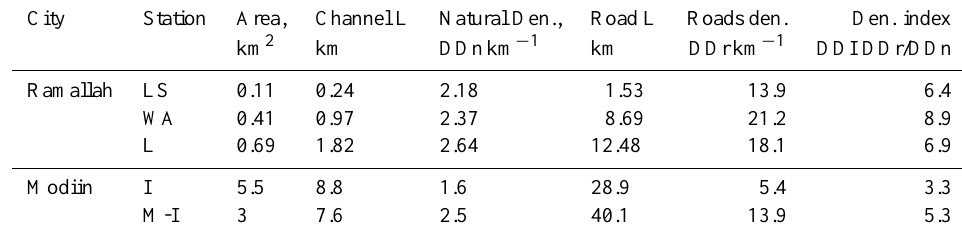
Table 6. Drainage density (DDI): natural areas previous to urbanization versus roads – Modiin and Ramallah. City Station Area, Channel L Natural Den., Road L Roads den. Den. index km 2 km Ramallah LS